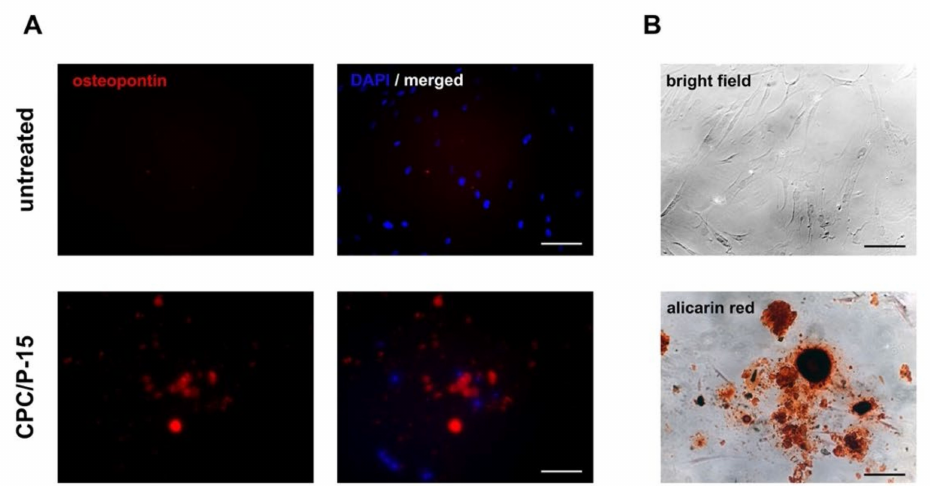
Figure 2. ( A ) Immunofluorescence staining of osteopontin and staining of Ca2+ deposits. ( B ) MESs cultured in a growth medium showed no osteopontin or Alizarin Red labeling When treated with CPC/P-15, osteopontin and Ca2+ deposits, colored red by the Alizarin Red staining, were detected after 10